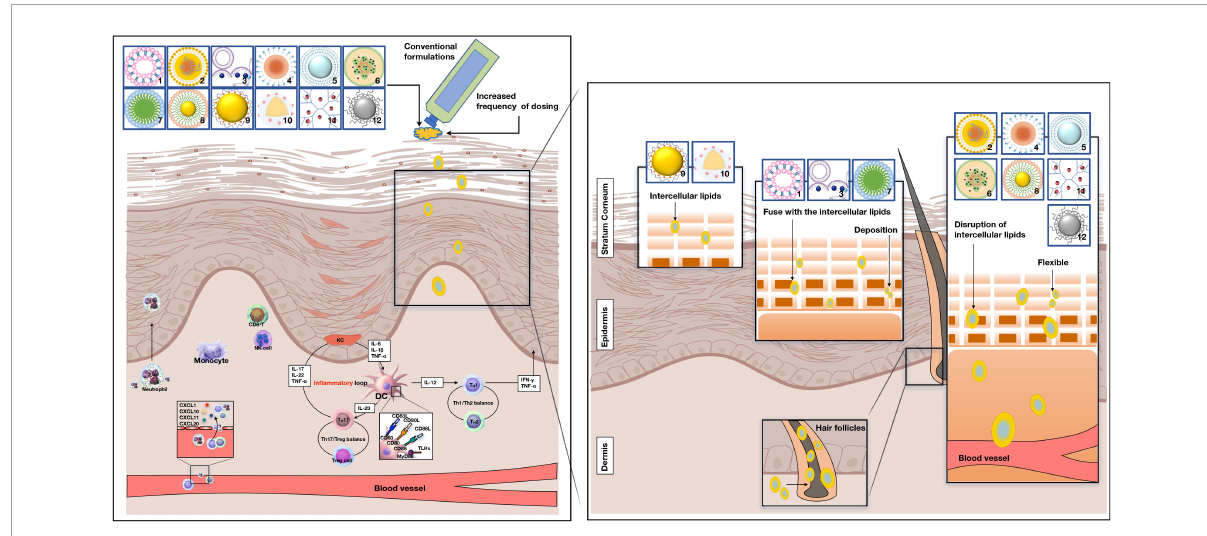
FIGURE1 Potential penetration routes of novel drug systems and conventional formulations. Pathogenesis of psoriasis is related to the KC/DC/T loop. 1: liposomes, 2: nanostructured lipid carriers, 3: niosomes, 4: nanoemulsions, 5: ethosomes, 6: solid lipid nanoparticles, 7: micelles, 8: gold particle, 9: nanocapsules, 10: nanosphere, 11: dendrimers, 12: sliver particle. pDC, plasmacytoid dendritic cells; DC, dendritic cells; KC, keratinocyte. NK -cell, natural killer cell; IL-17A, interleukin-17A; IL-17 F, interleukin-17 F; IL-17, interleukin-17; IL-12, interleukin-12. TNF- α , tumor necrosis factor- α ; IL-6, interleukin-6; IL-1 β , interleukin-1 β ; IFN- γ , interferon- γ ; Th1 cell, T helper 1 cells; Th2 cell, T helper 2 cell; Treg cell, T regulatory cells.